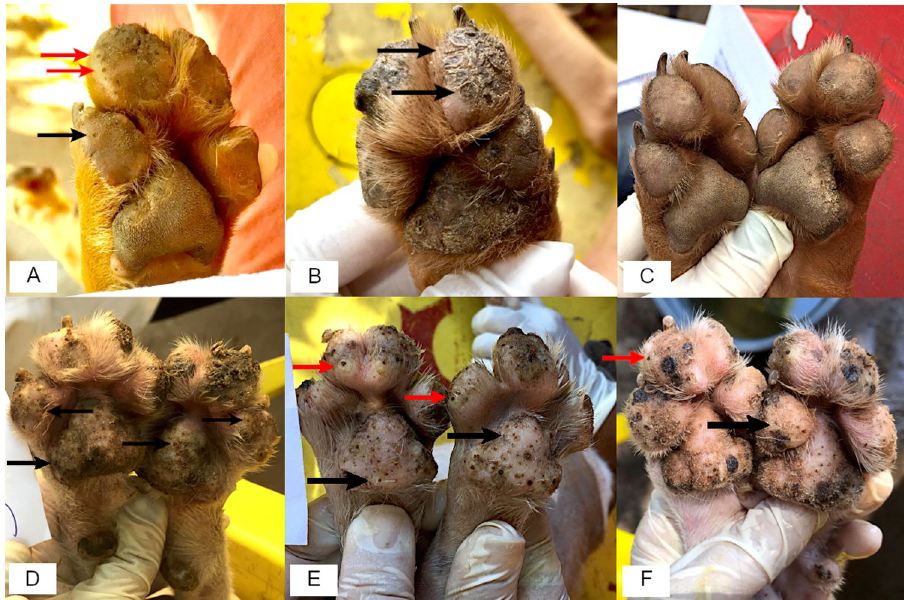
Fig 1. Front paws of fluralaner treated and untreated dogs. (A) Treated dog on day 0 showing multiple stage II (example in black arrow) and III (examples in red arrows) T . penetrans lesions. (B) Same dog day 7—no active lesions and visible parasite involution scars (stage V–examples in black arrows). (C) Same dog day 21—paw pad epithelium has regrown and pad is flea free (D) Untreated dog, on day 0 with multiple active flea lesions on the paw pads of the forelimbs (examples in black arrows). (E) Same untreated dog on day 7—numerous flea lesions in stages II (examples in black arrows) and III (examples in red arrows). (F) Same untreated dog—day 21, with flea active lesions II (example in black arrow) and III (example red arrow), indicating reinfestation. Notice that there are more lesions in Fig 1A, 1D, 1E and 1F than the arrows are showing. Source: author’s photographic collection. https://doi.org/10.1371/journal.pntd.0010251.g001 while from day 14 to 90, efficacy was > 95%, and was 100% from day 21 to 60. On day 120, effi- cacy was 84.4%. Similar results are obtained for efficacy based on arithmetic means of live flea counts. The geometric mean live sand flea count was significantly lower in treated dogs (p � 0.0036), from days 7 to 120. There was no significant difference between treated and untreated dogs on day 150 with efficacy < 10%. (Table 4). The effect sizes calculated as